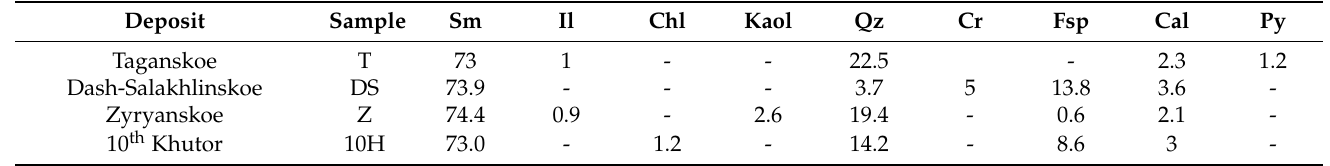
Table 1. Mineral composition of bentonite clay samples, wt.%